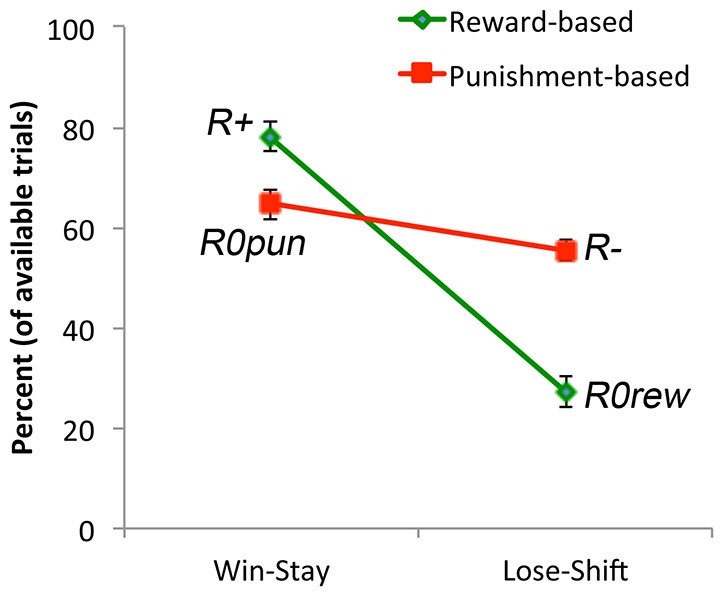
Win-stay occurs when subjects make a response to a stimulus and receive reward (or non-punishment) and then repeat the same response on the next trial with that stimulus. Subjects exhibited more win-stay responses following an explicit reward (R+) than following a non-punishment (R0pun). Lose-shift occurs when subjects make a response to a stimulus and receive punishment (or non-reward) and then make a different response on the next trial with that stimulus. Subjects exhibited more lose-shift responses following an explicit punishment (R−) than following a non-reward (R0rew).